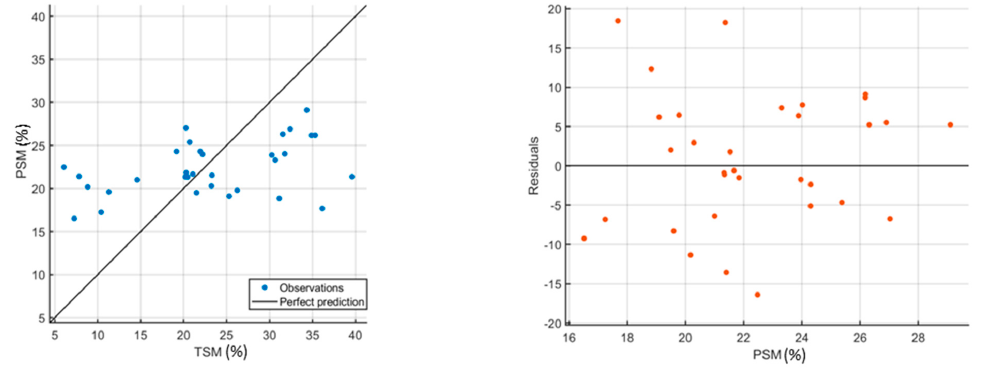
Figure 12. Scatterplots of the prediction performance of the five optimized ML models trained on the original non-augmented dataset for soil moisture retrieval. Left: predicted versus true soil moisture; Right: residuals versus predicted soil moisture. Blue dots represent the observations, the diagonal line represents the perfect prediction, and the orange dots represent the residuals. Table 5. Prediction performance of the fi ve optimized ML models trained on the original non-augmented dataset for soil moisture retrieval. Performance metrics are measured over an 8-Fold cross validation scheme and for 10% holdout test set. The entries of the best performing model are highlighted in grey color.